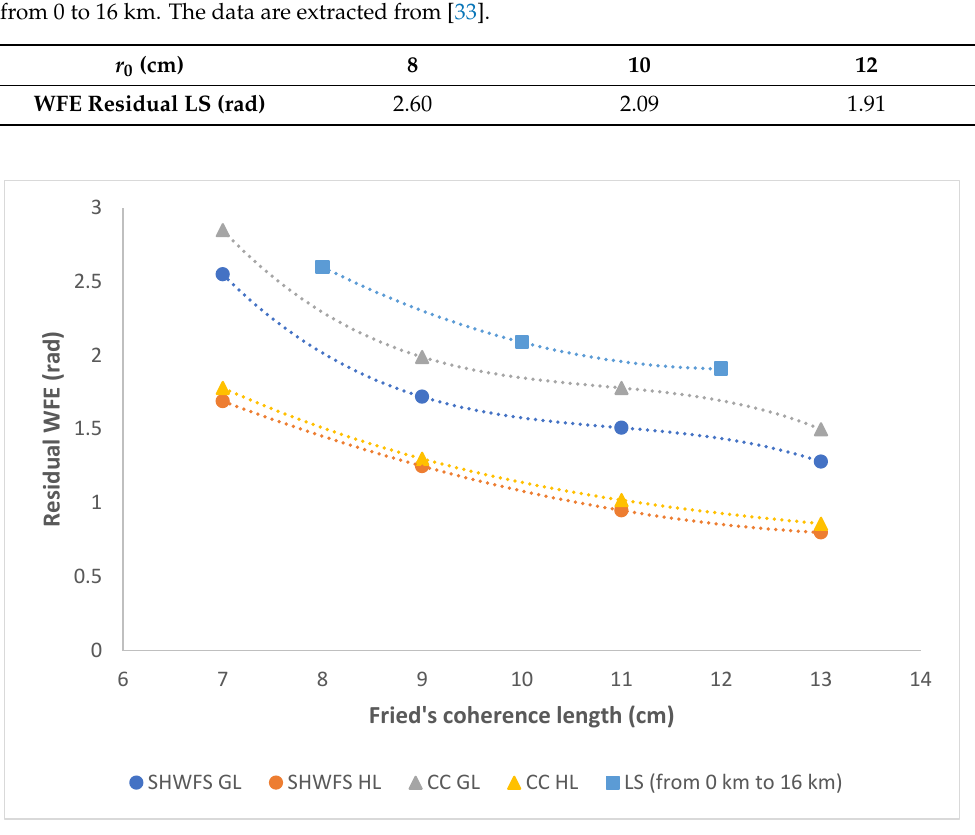
Figure 10. Comparison of the residual WFE obtained by both ANN methods in comparison with the most used algorithm in real Solar AO system based on the least squares (LS) method. The data for the LS reconstruction are extracted from [33]. A polynomial trend line of order 3 has been added for each case. Note that the range of altitudes for the LS method is higher than for the other ones. The markers in the figure are fixed for each model for easier comprehension.